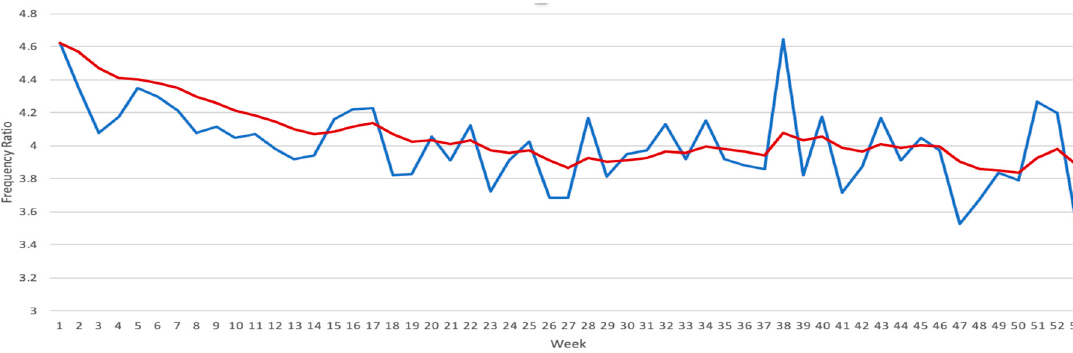
Figure 2. Proportion of patients with pneumonia over total admissions.